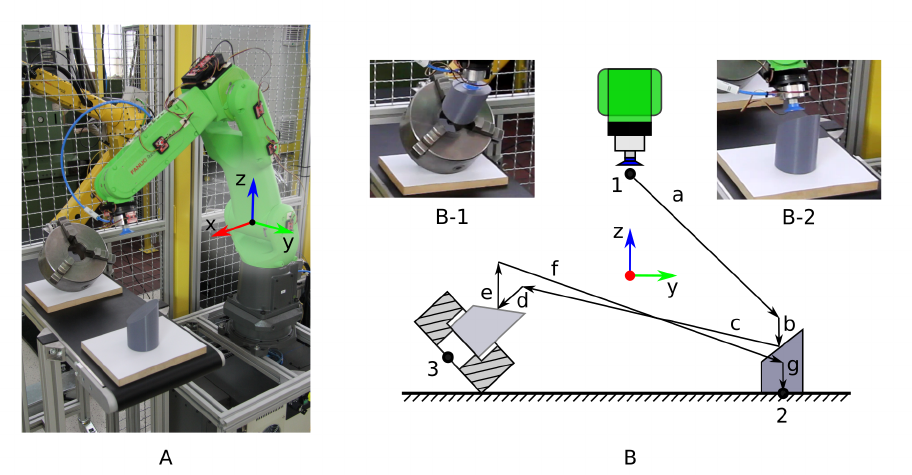
Figure 6. ( A ) The evaluation setup with a collaborative robot, workpiece, and fixture. ( B ) The view of the main movement plane. ( B-1 ) The insertion of the workpiece in the fixture. ( B-2 ) The approach to the